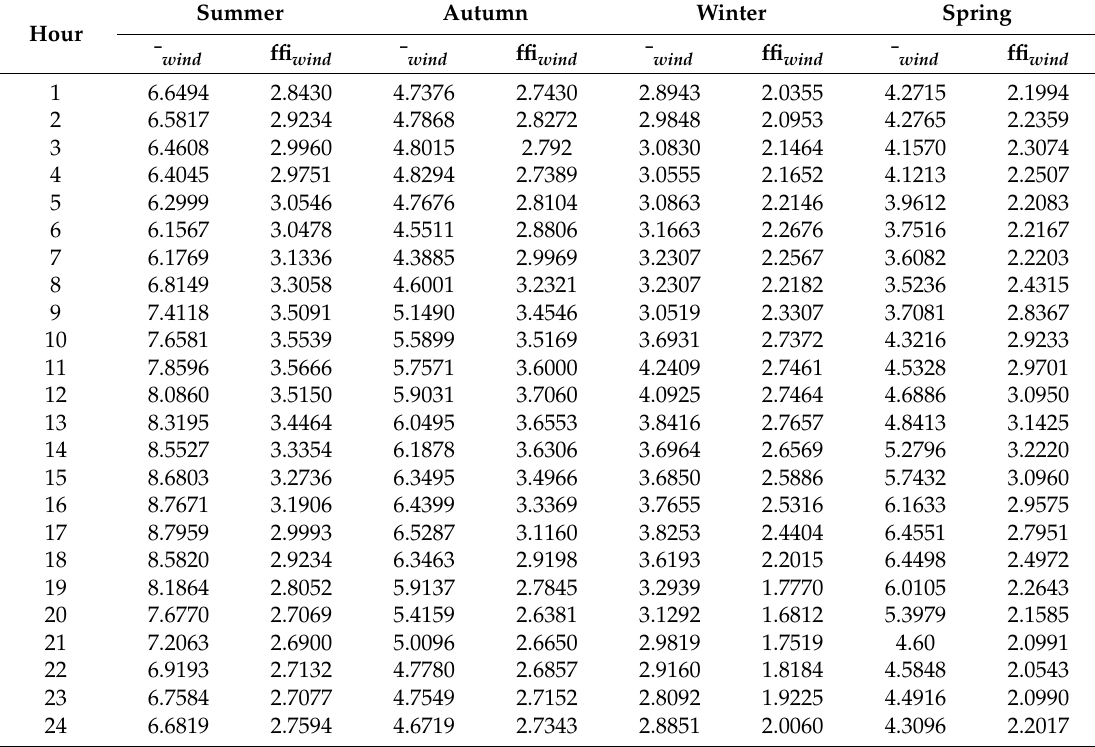
Figure 4. Probabilities of wind speed at each state during t th time hour. Table 2. Mean and standard deviation of wind speed in